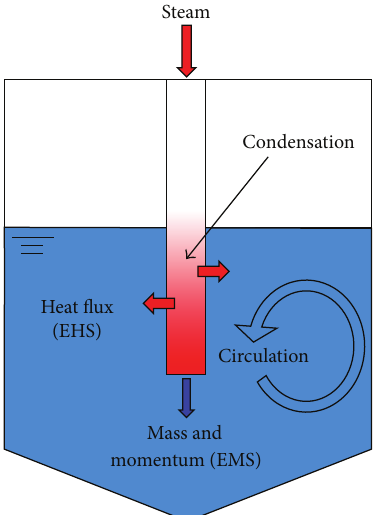
Figure 4: Schematic of effective heat source (EHS) and effective momentum source (EMS) models.